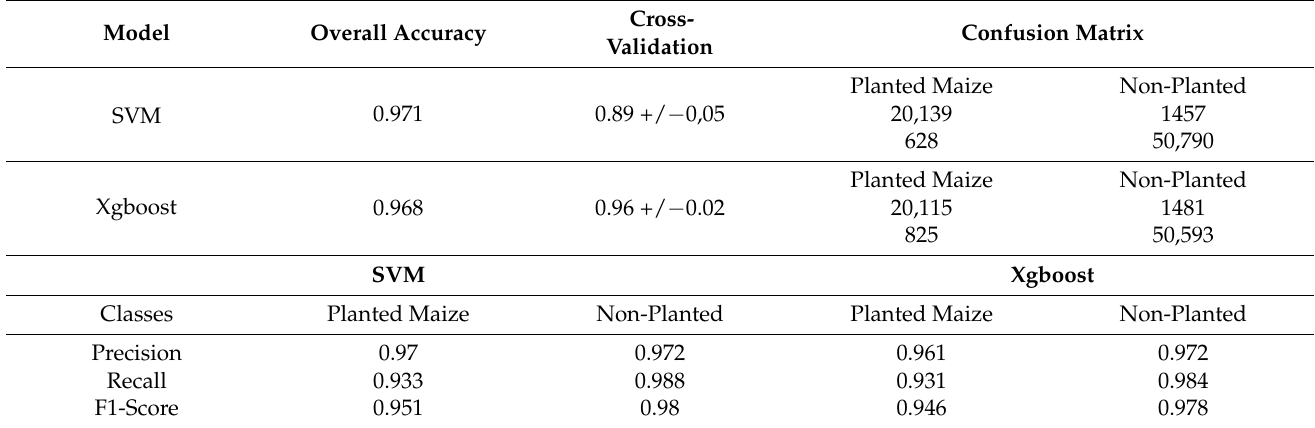
Table 2. Accuracy assessment produced for the Sentinel-1 multi-temporal classification using the Support Vector Machine (SVM) and Extreme Gradient Boosting (Xgboost)